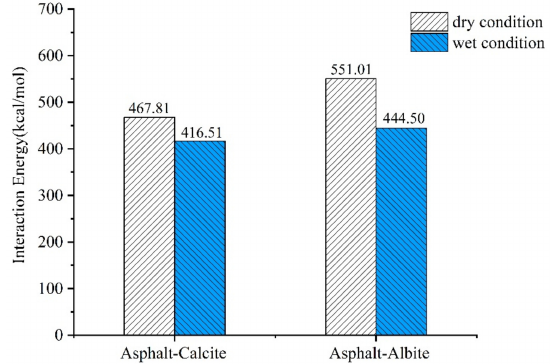
Figure 5. Adhesion works of the asphalt-aggregate system under di ff erent conditions.